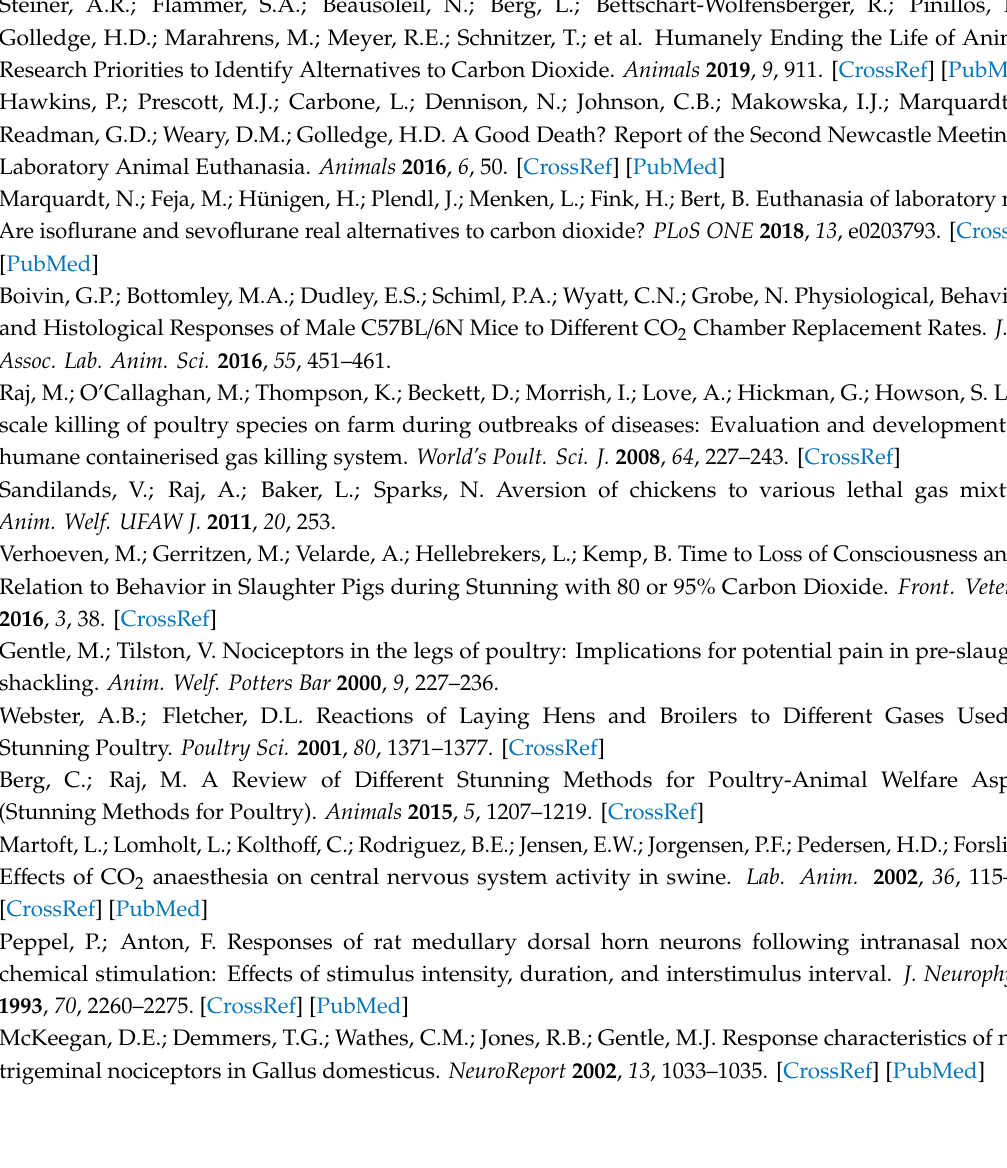
Figure S1: Schematic of home pen, Figure S2: Gas concentration and pressure curves, Video S1: Cessation of feeding, Video S2: Gasping—overhead view, Video S3: Gasping—side view, Video S4: Headshaking, Video S5: Wingflapping, Video S6: Ataxia, Video S7: Ataxia, Video S8: Loss of posture, Video S9: Open mouth